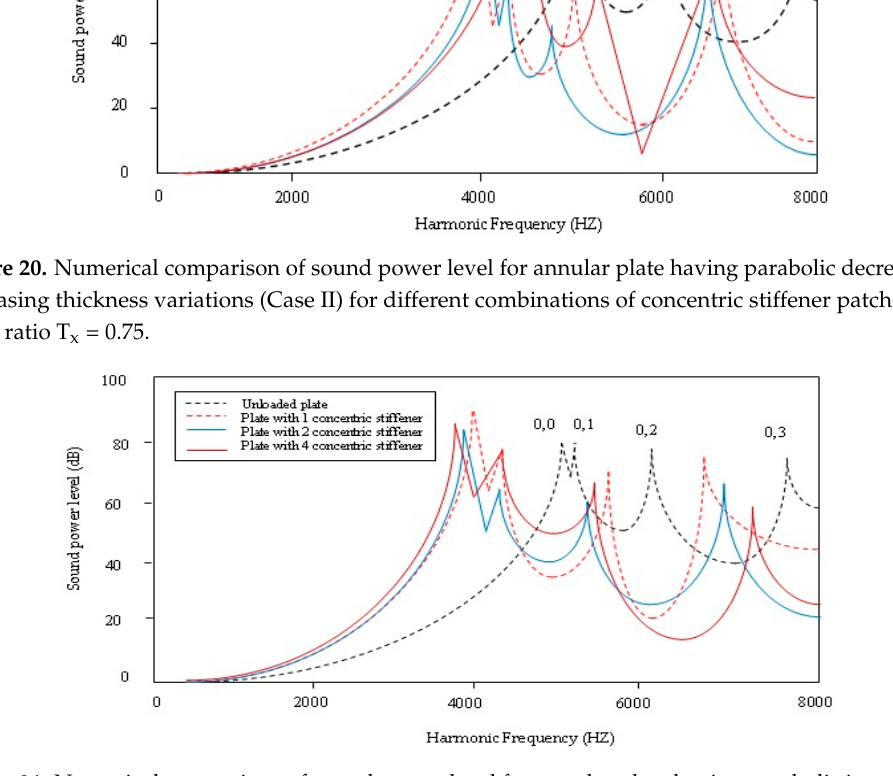
Figure 21. Numerical comparison of sound power level for annular plate having parabolic increasing decreasing thickness variations (Case III) for different combinations of concentric stiffener patches for taper ratio T x = 0.75.